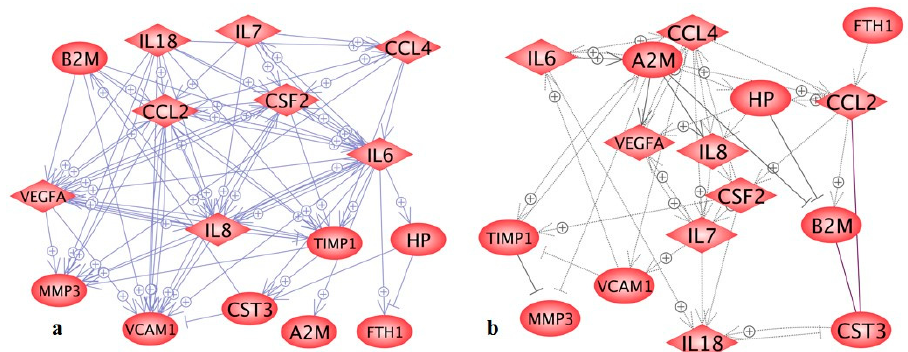
Figure 2. Relationships of the 16 proteins found in the supernatants of the Cellbox-1 experiments (see Table 1). ( a ) Mutual genetic regulation ( b ) Interaction and regulation on the protein level (solid lines indicate binding; arrows indicate direct regulation).